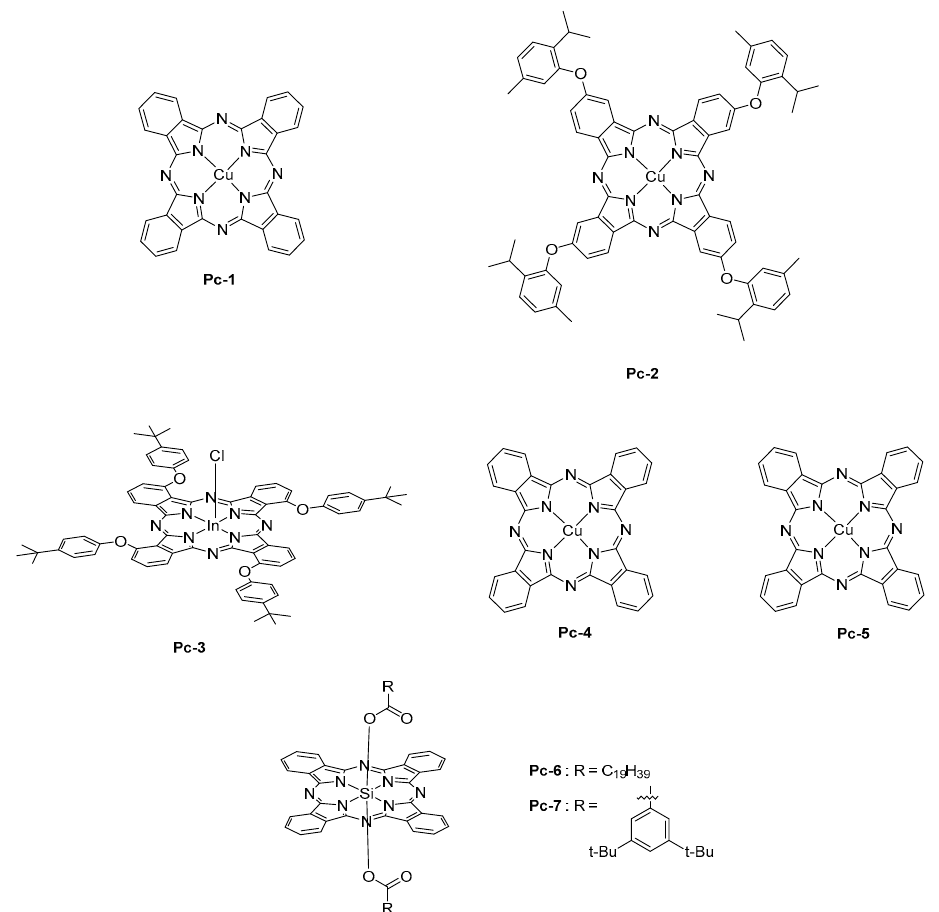
Figure 13. Phthalocyanine-based near-infrared (NIR) emitters for light-emitting diodes.